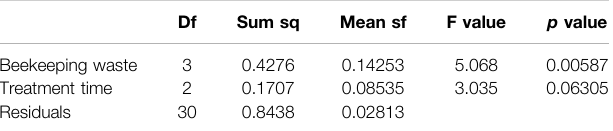
TABLE 2 | Results of the analysis of variance (ANOVA) of the wavelength intensity of the Raman spectrum.